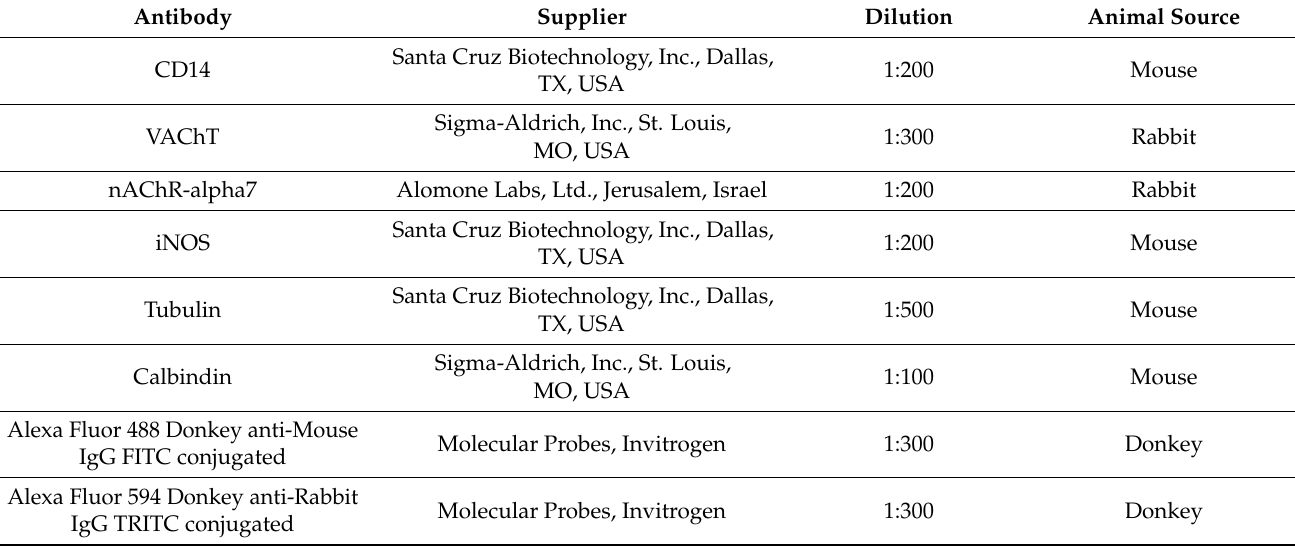
Table 1. Antibodies used in this